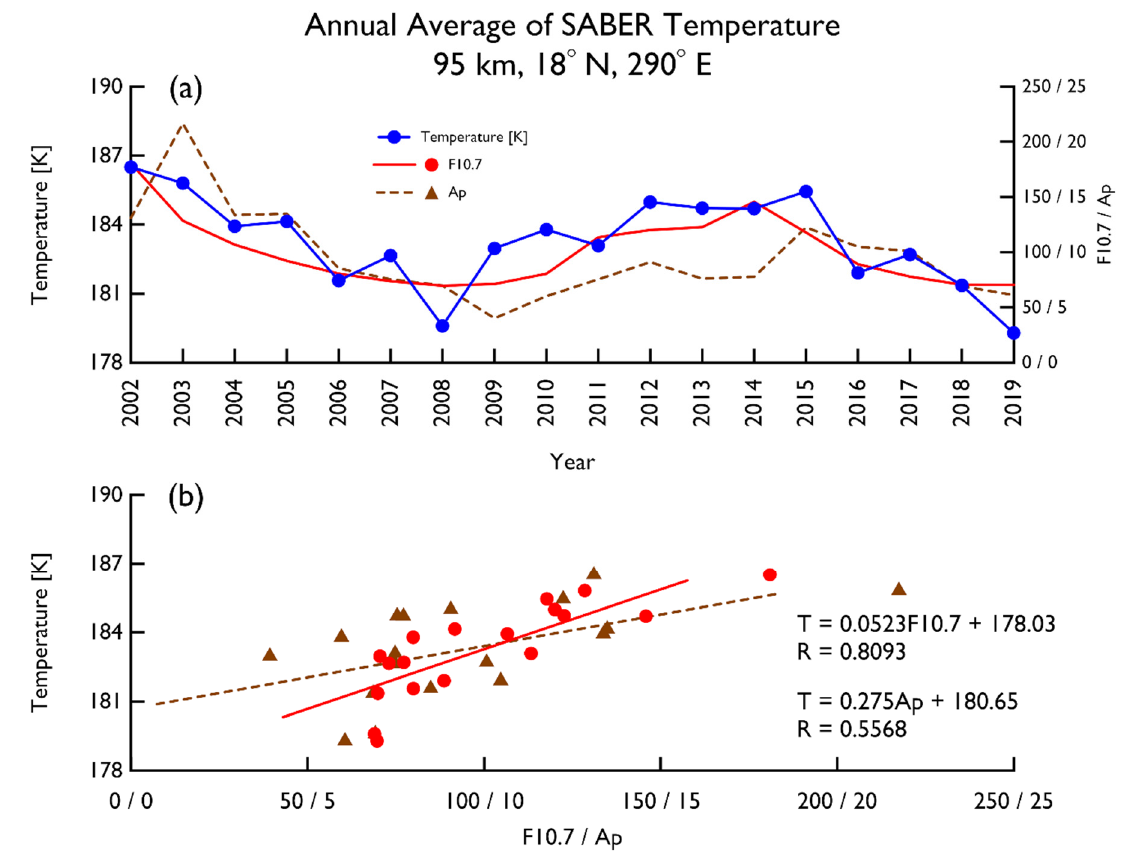
Figure 2. Annual average of SABER temperature at 18° N, 290° E at 95 km. ( a ) Time series of temperature (blue line with dots), F10.7 (red line), and Ap index (brown dashed line). ( b ) Trend analysis of temperature as a function of the F10.7 (red line and dots) and of the Ap index (brown dashed line and triangles).